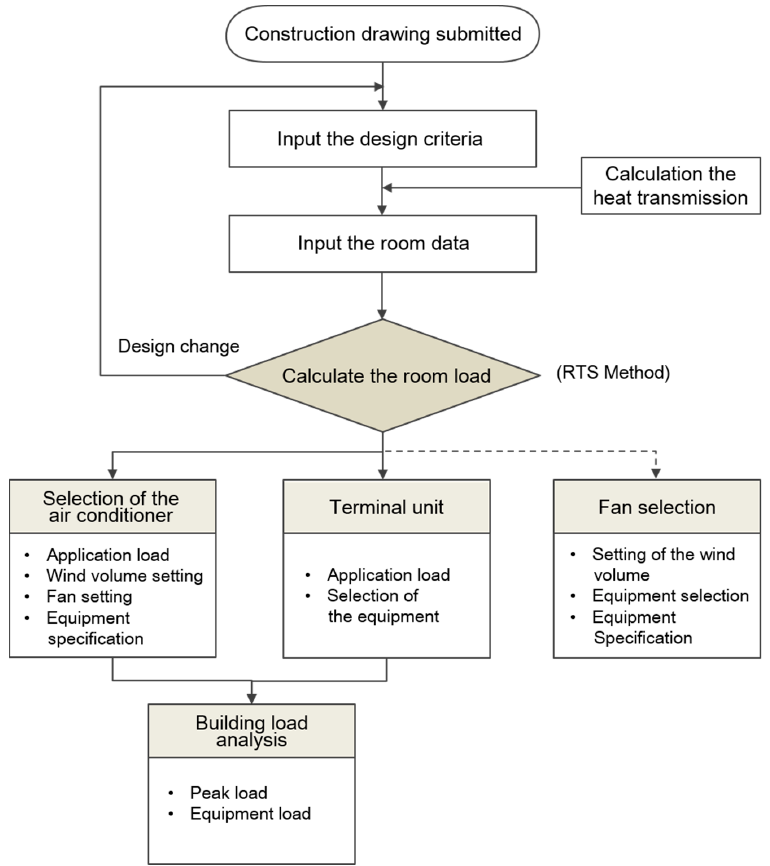
Figure 2. Load calculation process of RTS-SAREK program.